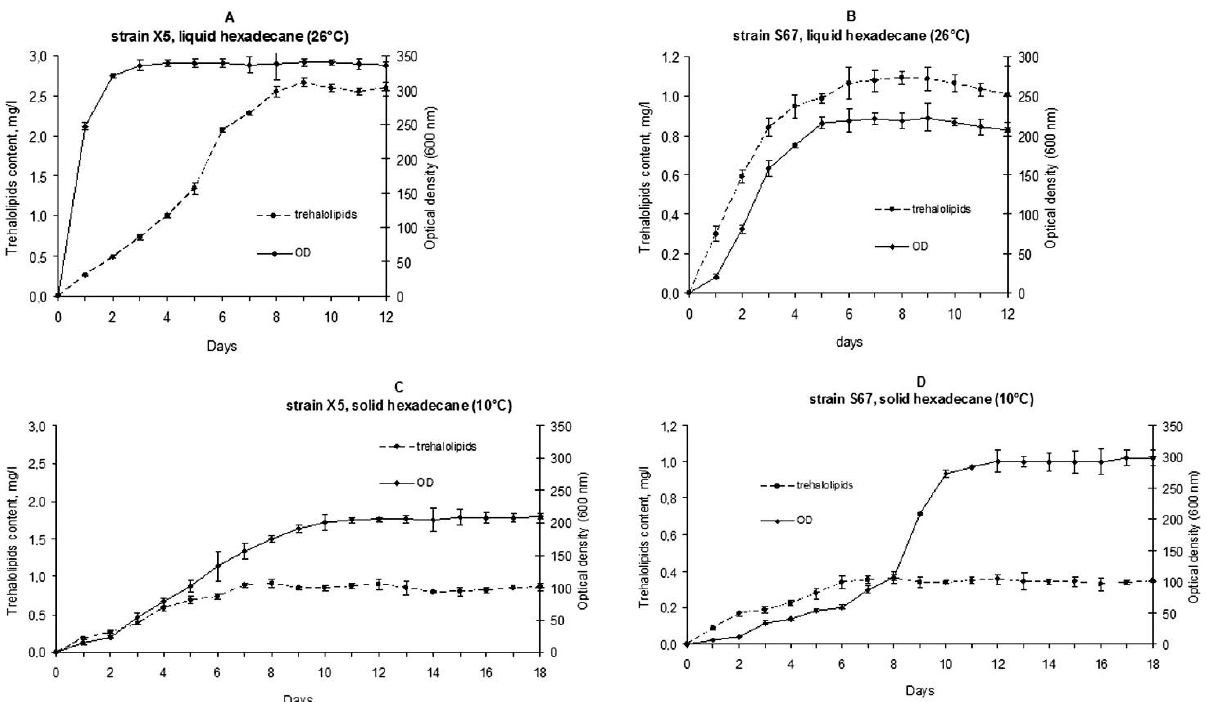
Figure 1. The kinetics of cell growth and trehalolipids contents for strains X5 and S67 during batch cultivation in Evans medium with hexadecane at 26 °C ( A , B ) and 10 °C ( C , D ).